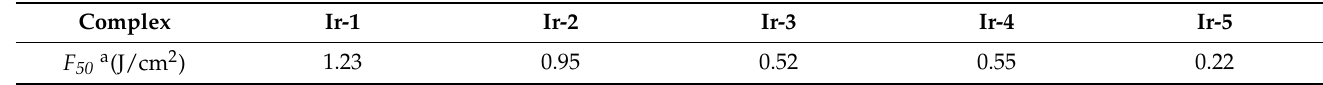
Figure 4. Output fluence vs. incident fluence for complexes Ir-1 – Ir-5 in CH 3 CN, and C 60 in toluene at 532 nm using a 4.1 ns laser pulse. Table 5. The F 50 of Ir